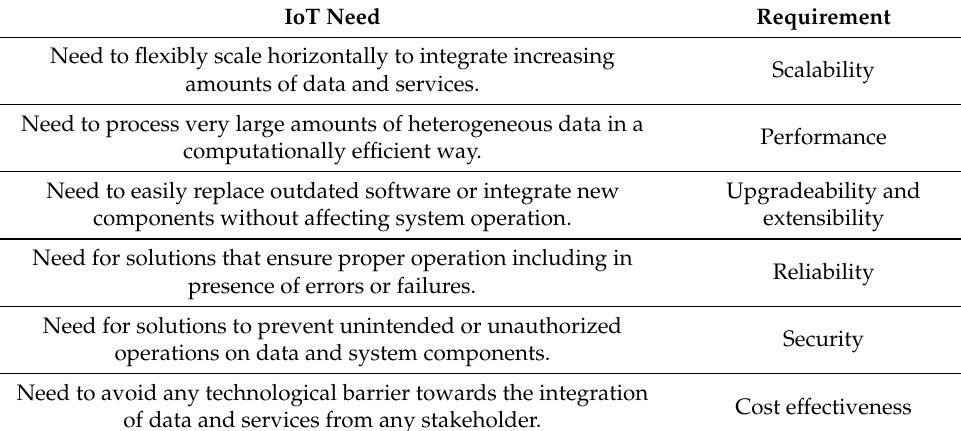
Table 3. Non-functional requirements for IoT-based architectures. IoT Need Requirement